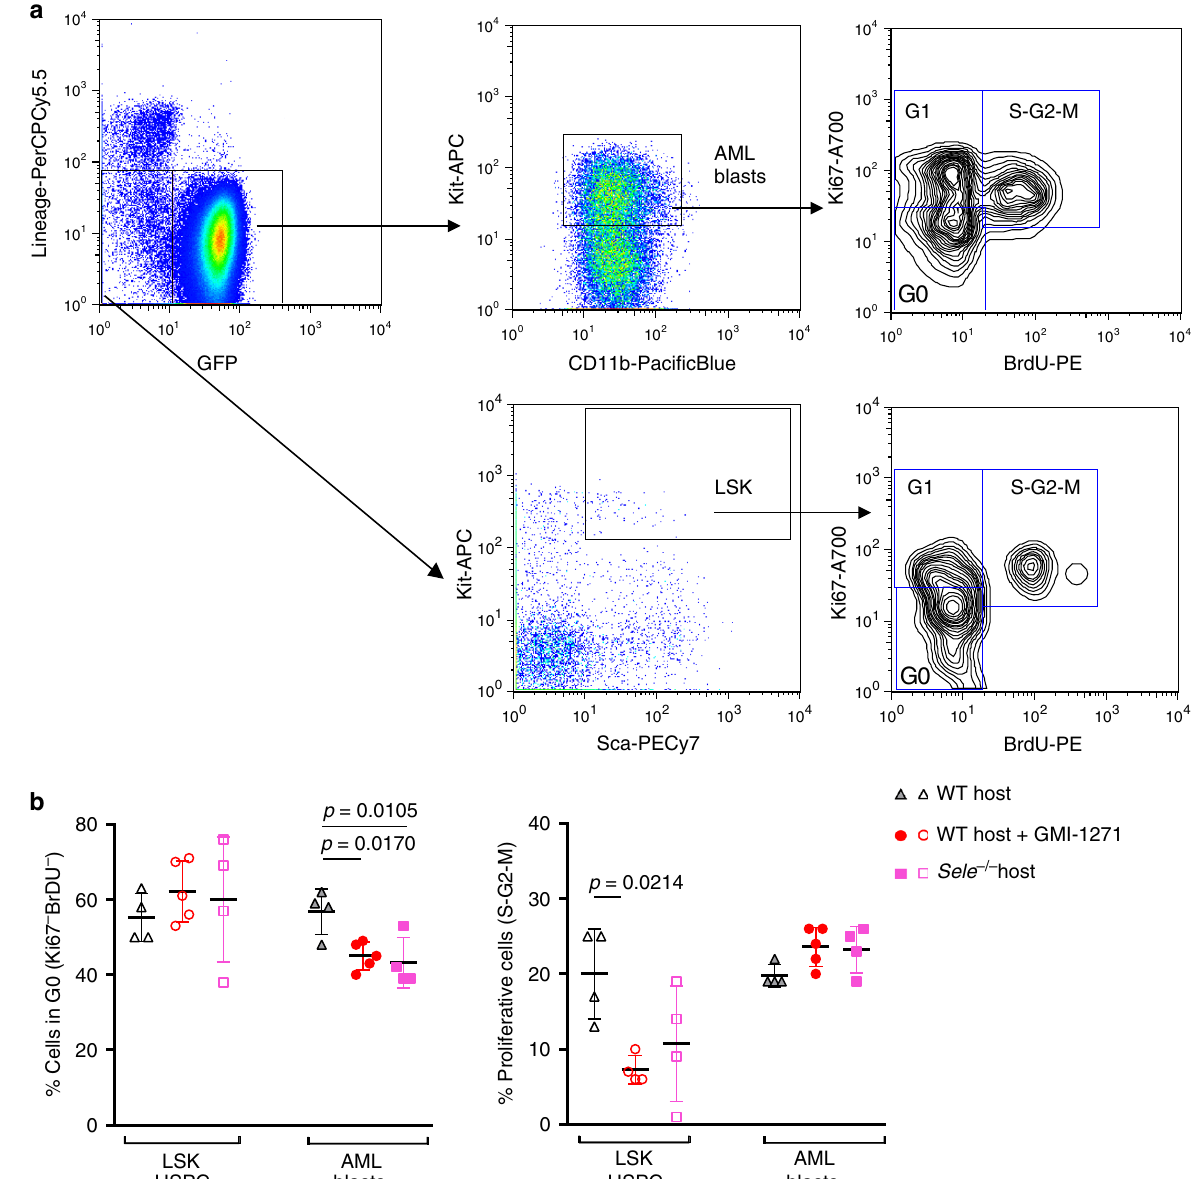
Fig. 4 Absence or blockade of E-selectin stimulates quiescent AML blasts to cycle, while HSPC remain dormant. a Flow cytometry dot plots showing gating strategy for AML blasts (GFP + Lin − KIT + CD11b + ) and HSPC (GFP − Lin − KIT + Sca1 + , LSK) within the same leukemic host from mice administered 24 h BrdU. The cell cycle phases were de fi ned as G 0 (Ki-67 − , BrdU − ), G 1 (Ki-67 + , BrdU − ) and S-G 2 -M (Ki-67 + , BrdU + ). b Histograms show percentage of bone marrow LSK HSPC and AML blasts in quiescence (phase G 0 , left panel ) and proliferative (BrdU + , right panel). Each dot represents data from an individual mouse. Shown are mean ± S.D., n = 4,5,4 mice/group. Statistical analysis performed by one-way ANOVA multiple comparison Bonferroni correction. Source data are provided as a Source Data fi agitation at 37°C to release endosteal cells which were then collected by fl ush with femur represents 5.6% total BM, and total blood volume of a mouse calculated as PBS and analyzed by fl ow cytometry 6 . 0.8 mL peripheral blood per 10g body weight. Collection and staining of healthy patient BM HSC and leukemia cells were approved by the Peter MacCallum Cancer Centre ethics committee (Project 01/40) and Queensland Metro South Human Ethics Committee (HREC/2019/QMS/ 46799). All collections were from consenting adult patients that sequentially presented to clinic. Donor BM cells were collected from normal healthy BM donors ( n = 2) or from BM associated with acetabulum reaming from patients undergoing arthroplasty ( n = 2). AML cells were collected from blood or BM of patients at the same time as standard of care collection ( n = 2). Mononuclear cells were enriched for CD34 + cells using anti-CD34 conjugated MACs beads and auto-MACs POSSEL separation following manufacturer ’ s instructions. Cells were then stained for fl ow cytometry. Calculation of whole body AML blast numbers in BM and blood for Supplementary Fig. 3 were performed as previously described 55 . In summary one